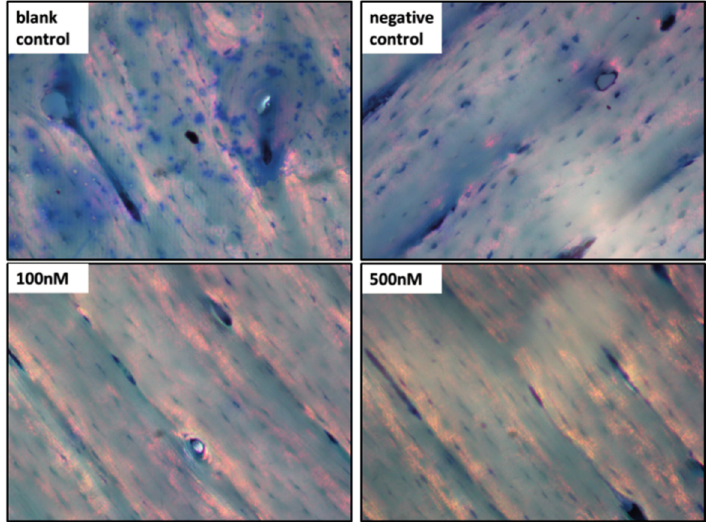
Figure 5. Bone resorption by OCs induced by RANKL and M-CSF. The bone slices were rinsed and left overnight in 1 M ammonium hydroxide to remove all cells. The slices were then washed with PBS and stained with 0.5% toluidine blue. The resorption pits were identified by microscopy (original magnification 200×). Each experiment was carried out in